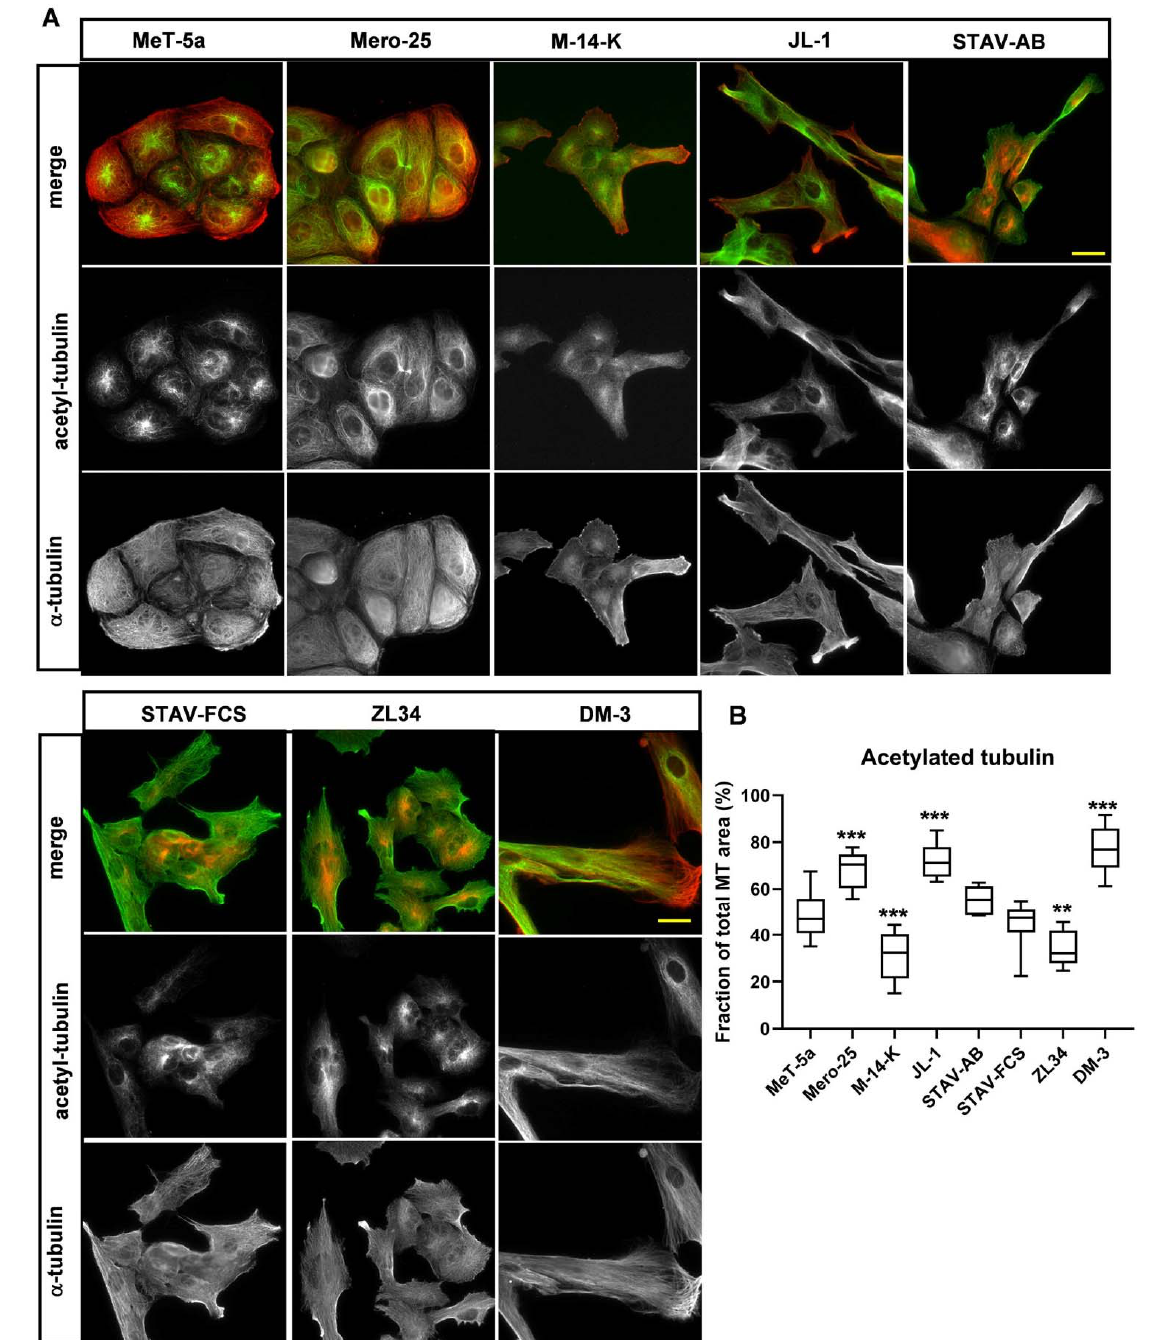
Figure 4. Organization of stable microtubules. ( A ) Stable microtubules were visualized with a mouse antibody against acetylated tubulin followed by an AlexaFluor488-conjugated goat anti-mouse antibody (for MeT-5a, Mero-25, M-14-K, JL-1 and DM-3) or an AlexaFluor568-conjugated goat anti-mouse antibody (for STAV-AB, STAV-FCS and ZL34). Microtubules were visualized with a rabbit antibody against acetylated tubulin followed by an AlexaFluor568-conjugated donkey anti-rabbit antibody (for MeT-5a, Mero-25, M-14-K, JL-1 and DM-3) or an AlexaFluor488-conjugated goat anti-rabbit antibody (for STAV-AB, STAV-FCS and ZL34). Scale bar, 20 µm. ( B ) The proportion of the microtubules that are also positive for acetylated tubulin was examined by microscopy imaging. Ten images from three independent experiments for each cell line were analyzed using ImageJ. One-way ANOVA with Tukey’s post hoc analyses were made to calculate statistical significance. ** = p < 0.01 and *** = p < 0.001 mark the statistical significant difference compared to MeT-5a. A complete list of the significances of the data is presented in Table